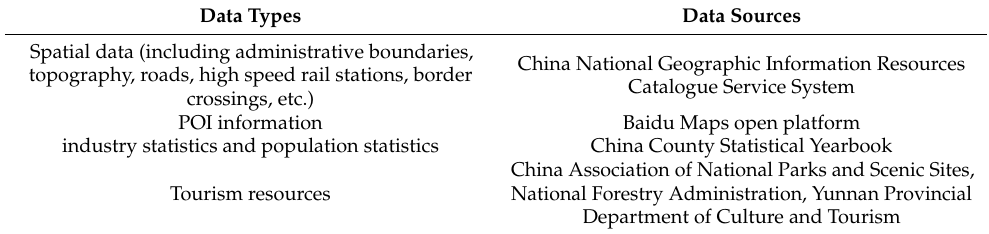
Table 3. Data sources.